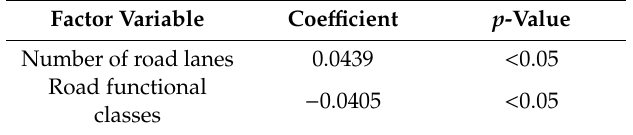
Table 6. Correlations results between the road structure and hot